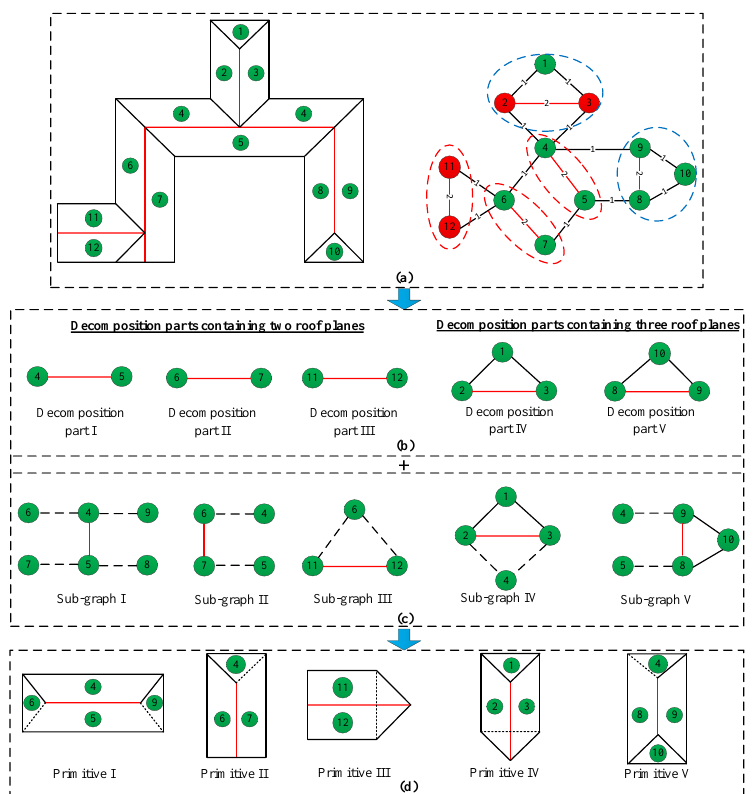
Figure 6. The recognition of each primitive in the corresponding decomposition part. ( a ) A compound building and its attributed graph; ( b ) the segmented planar patches contained in each decomposition part; ( c ) the sub-graph of each decomposition part; and ( d ) the recognized primitive in each decomposition